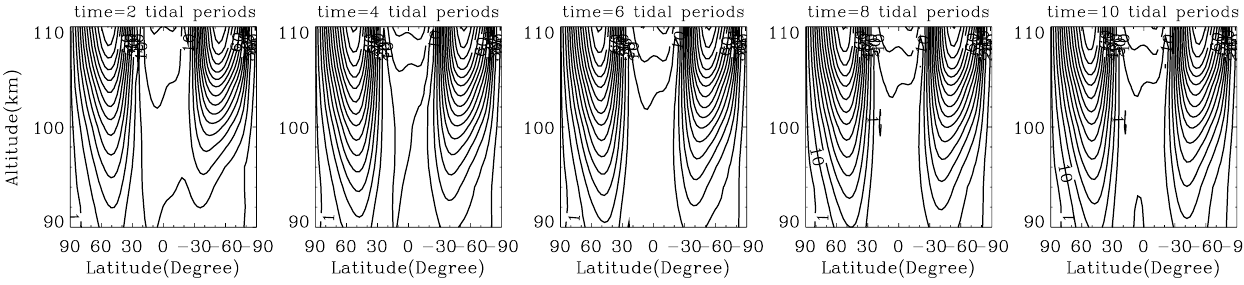
Fig. 7. Temporal evolution of the zonal-wind amplitudes within 10 tidal periods for March deduced from the linear propagation solution of the migrating semidiurnal tide starting from zero tidal oscillations. The minimum values of the contours are 1ms − 1 , and the intervals of the contours are 5ms − 1 when the amplitudes are greater than 5m/s.